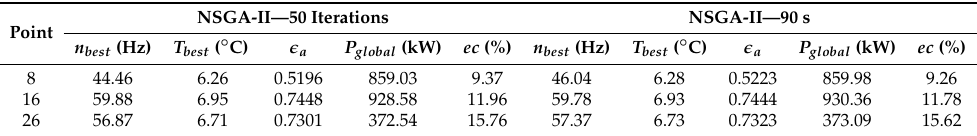
Table 6. Optimal solutions obtained by NSGA-II for the 4 operational points.